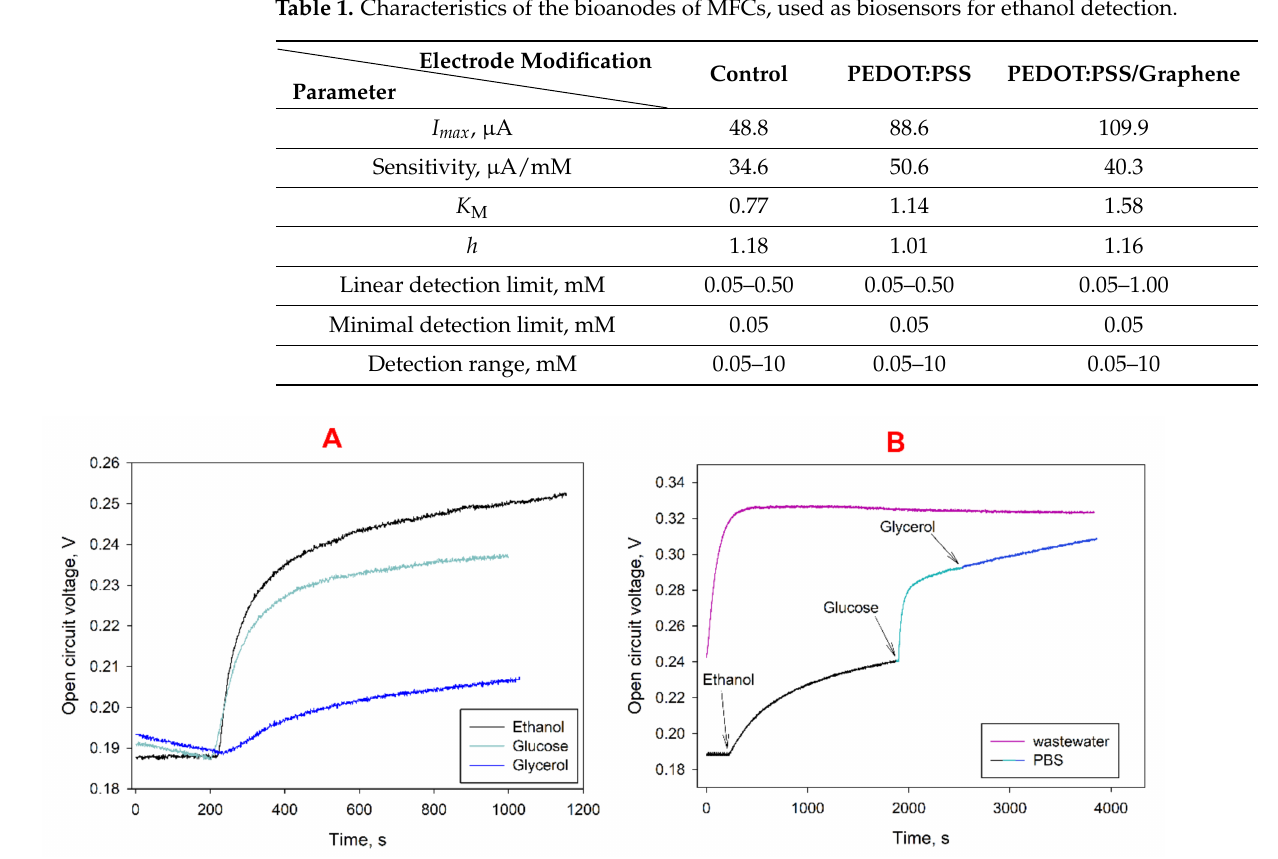
Figure 4. Change of MFC open circuit voltage at the introduction of three separate substrates into anolyte ( A ) or when using PBS with the sequential addition of substrates/municipal wastewater as anolyte ( B ). Concentrations of added substrates, 1